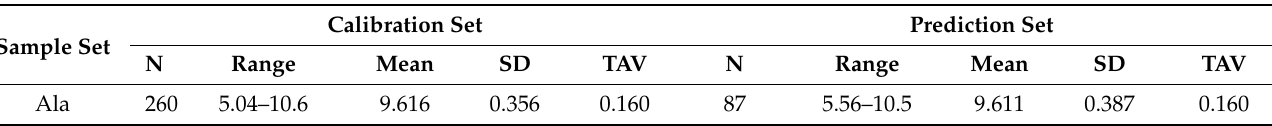
Table 3. Statistical results of beef sample set divided by the RS method.